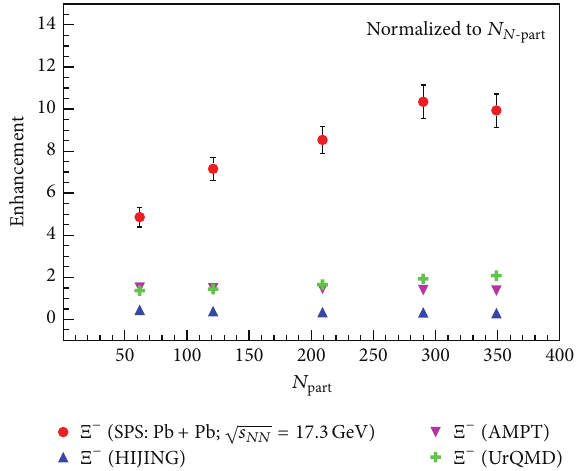
Figure 6: 𝑁 𝑁 -normalized enhancements of Ξ − as a function of -part collision centrality for Pb + Pb collisions at √𝑠 𝑁𝑁 = 17.3 GeV are compared with HIJING, AMPT, and UrQMD models at midrapid- ity.